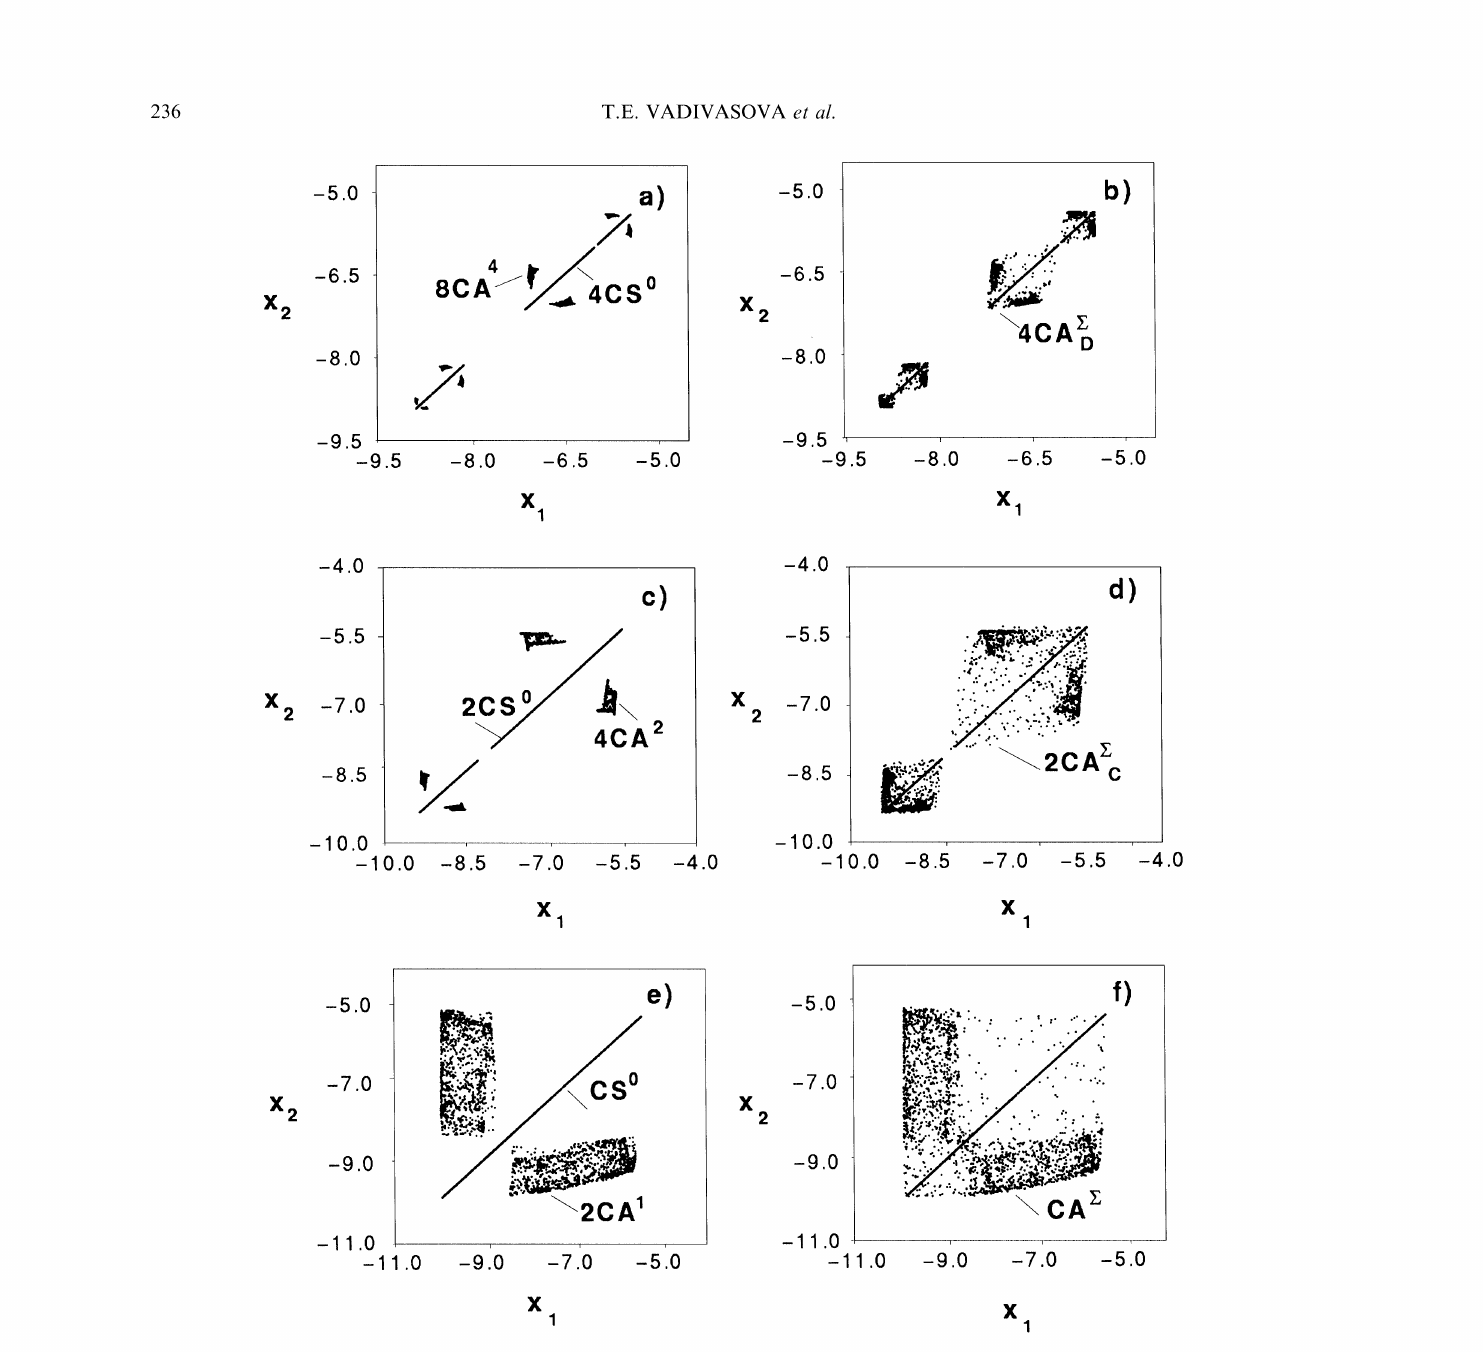
FIGURE 2 Projections of Poincar6 sections of chaotic sets for the identical coupled R6ssler systems. Secant plane is specified as y =0. Label "CS" is used to identify a saddle